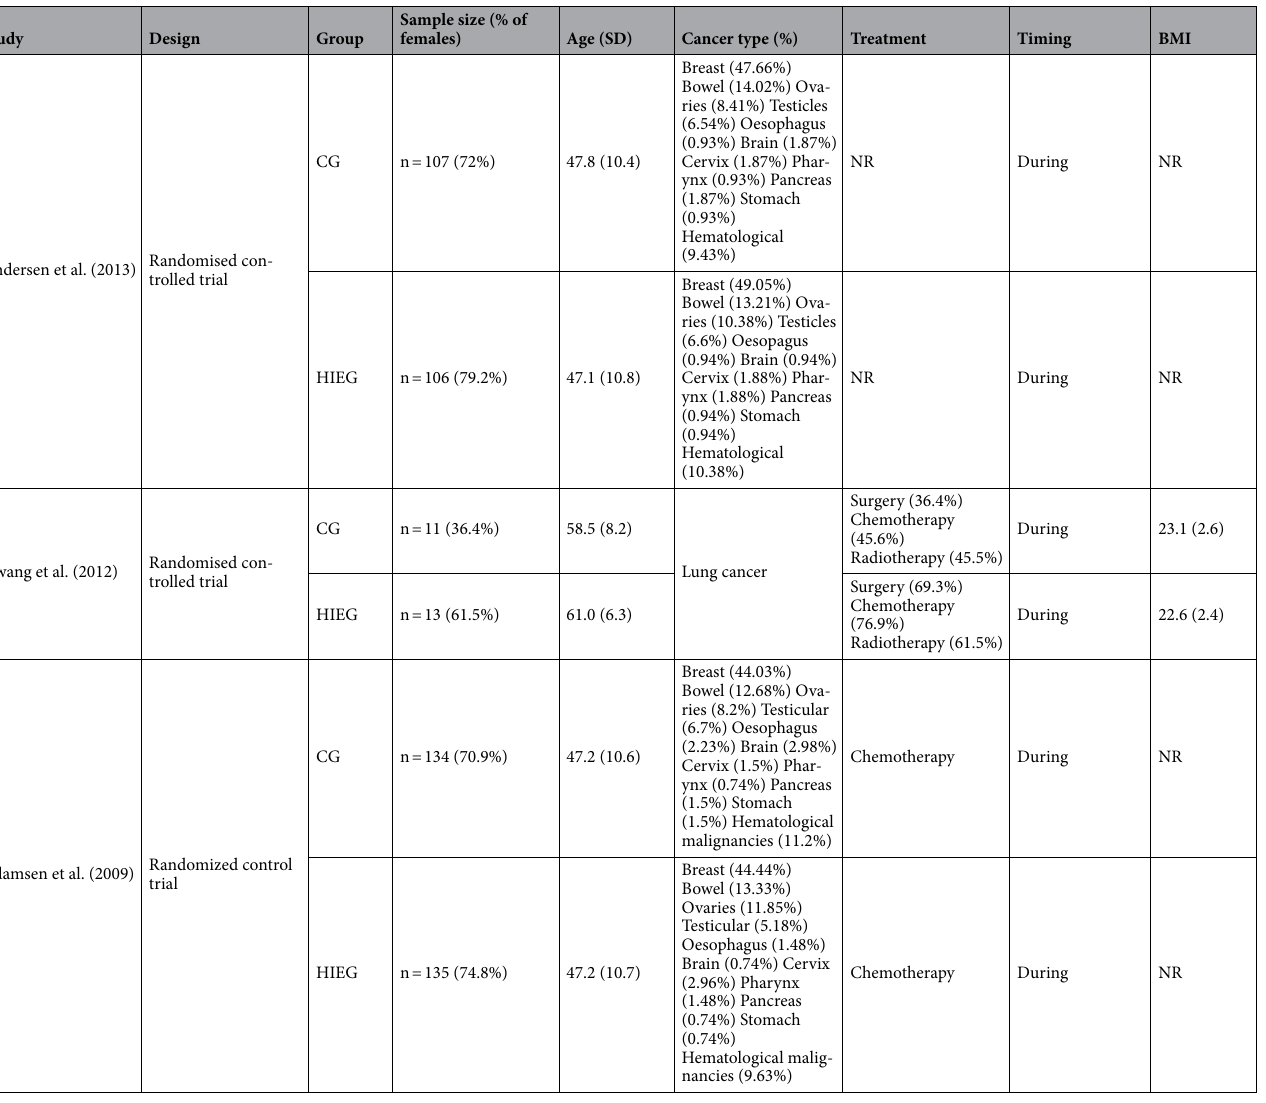
Table 2. Baseline characteristics of the participants included in the meta-analysis. CG: control group, HIEG: high-intensity exercise group, HIEG-R: high-intensity resistance exercise group, HIEG-E: high-intensity endurance exercise group, LIEG: low-intensity exercise group, LMIEG: low to moderate exercise group, NR: not